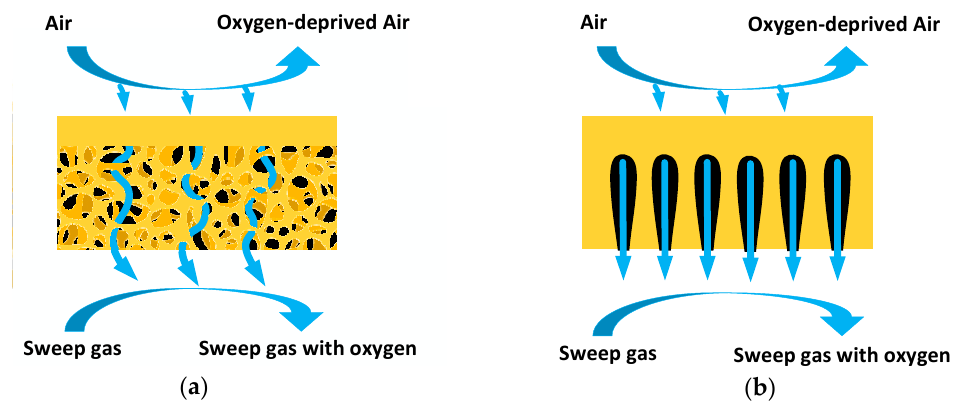
Figure 1. Schematic illustration of gas transport through porous supports with ( a ) sponge-like microstructure and ( b ) micro channels.